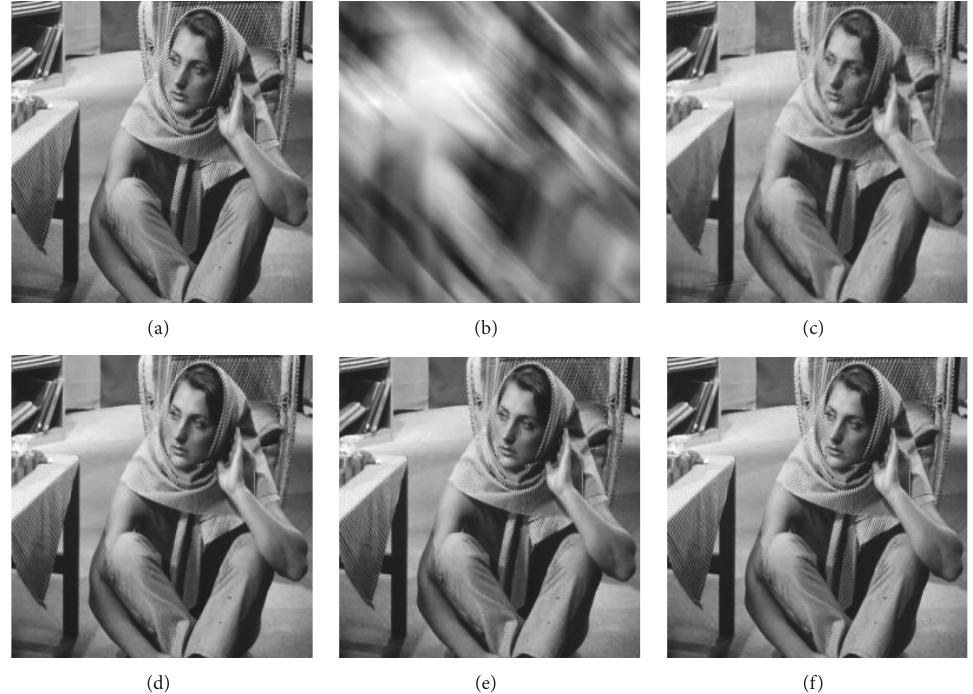
Figure 7: Restoration results of the Barbara image with motion blur kernel. (a) Original image; (b) blurred and noisy image; (c) image recovered by FTVd; (d) image recovered by TGV; (e) image recovered by TVframe; (f) image recovered by TGVframe.